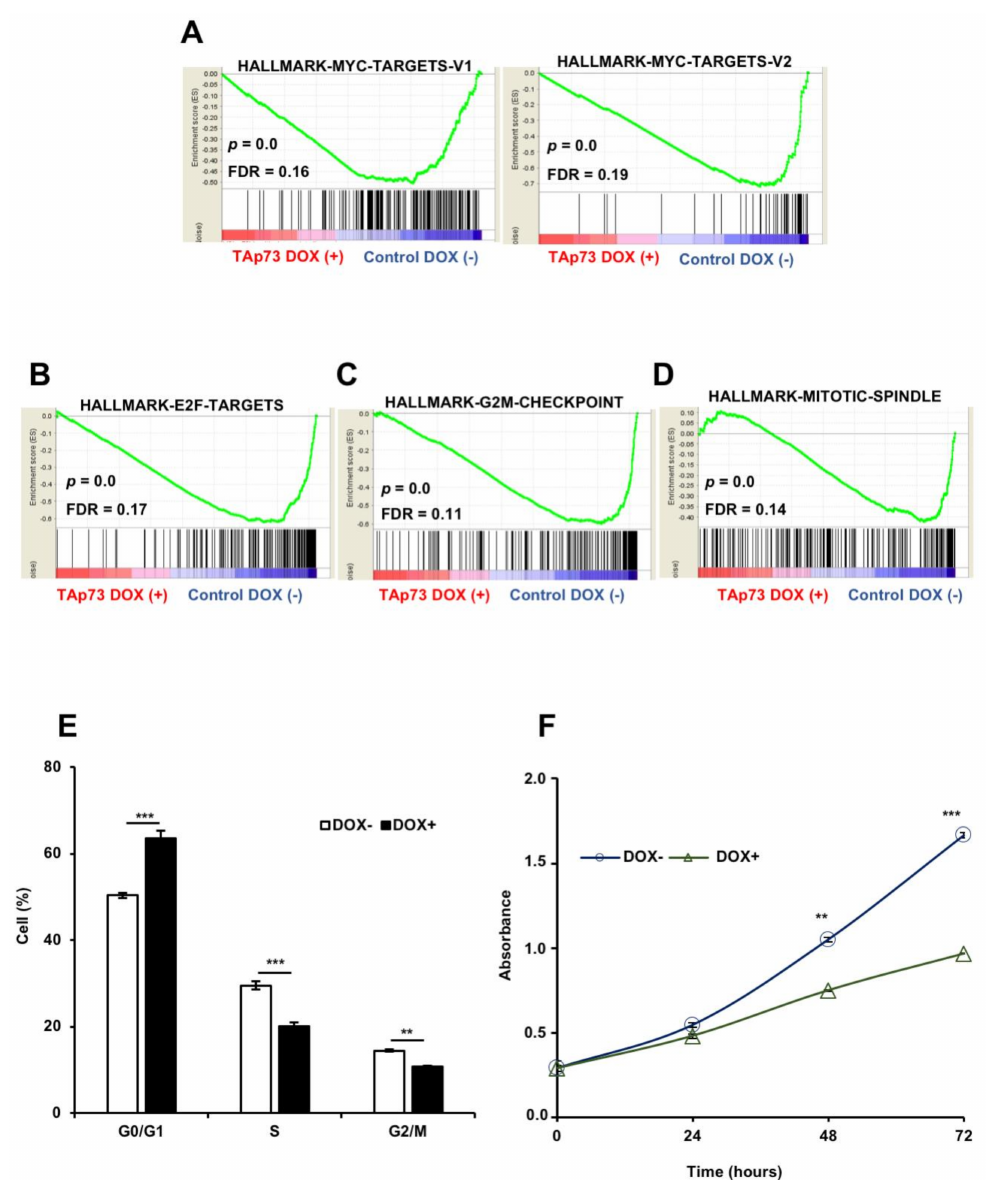
Figure 3. TAp73 β down-regulates cell proliferation by increasing the proportion of cells at G0/G1 phase at the expense of S and G2/M phase cells. Gene set enrichment analyses showing the repression of ( A ) Myc-target genes, ( B ) E2F target genes, ( C ) genes involved in G2/M cell cycle progression, and ( D ) mitotic spindle associated genes. ( E ) TAp73 β causes moderate inhibition of cell cyle progression by increasing the relative number of cells at G0/G1 phase. Hep3BTAp73 β cells were treated with doxycycline (1 µ g/mL) for 72 h, and cell cycle distribution was evaluated by using flow cytometric DNA content analysis. ( F ) TAp73 β decreases cell proliferation by 40%, but does not stop cell growth. Hep3BTAp73 β cells were exposed to doxycycline (1 µ g/mL) for 0 h, 24 h, 48 h and 72 h. At the end of the indicated times, cell proliferation was measured by the SRB method. Columns and error bars indicate ± SD from triplicate experiments. ** p < 0.001 and *** p < 0.0001 for significant differences between cells treated and not treated with